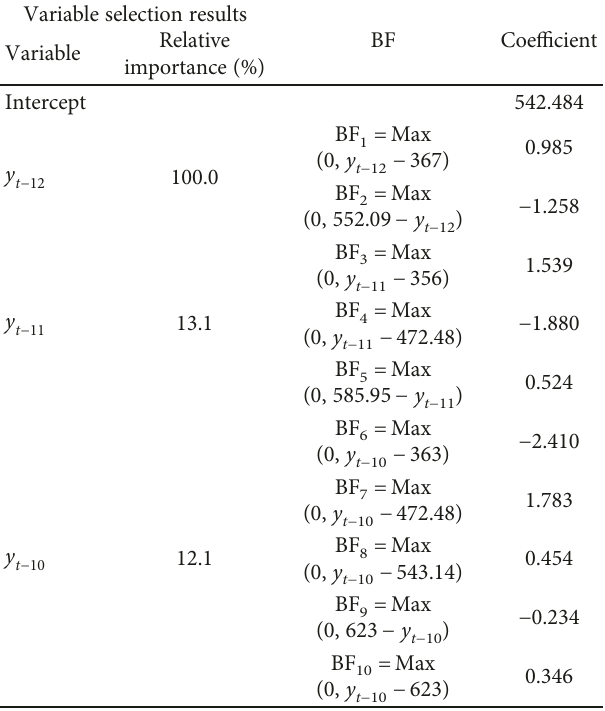
Table 5: The results of ARIMA-MARS for rice price forecasting. Variable selection